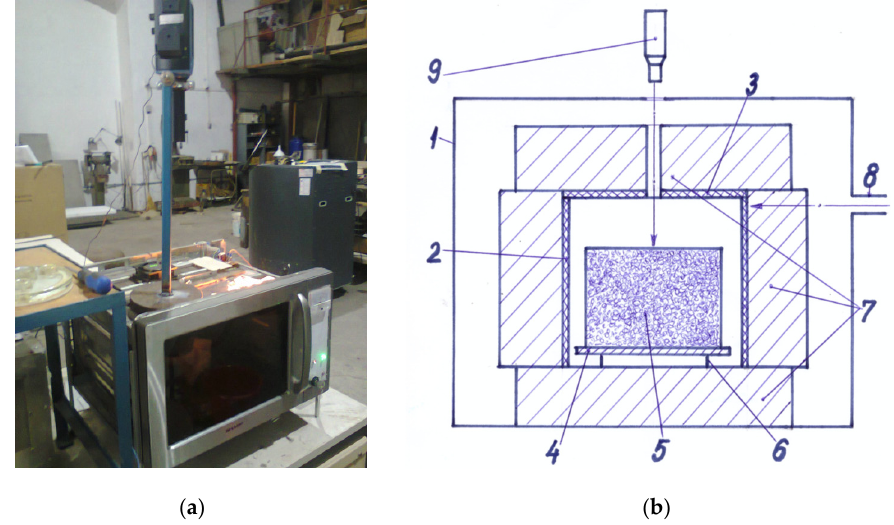
Figure 1. Experimental microwave equipment: ( a ) Overall image of the experimental equipment; ( b ) Constructive scheme of the experimental equipment: 1—0.8 kW-microwave oven; 2—ceramic tube; 3—ceramic lid; 4—metal plate; 5—pressed powder mixture; 6—metal support; 7—thermal insulation; 8—waveguide; 9—pyrometer (Reproduced by permission of Daily Sourcing and Research SRL).